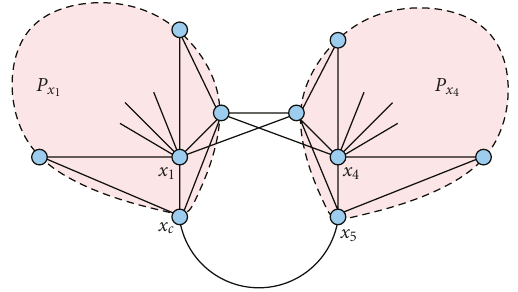
Figure 2: The flower graph not localizable for r − 1, uniquely localizable for r